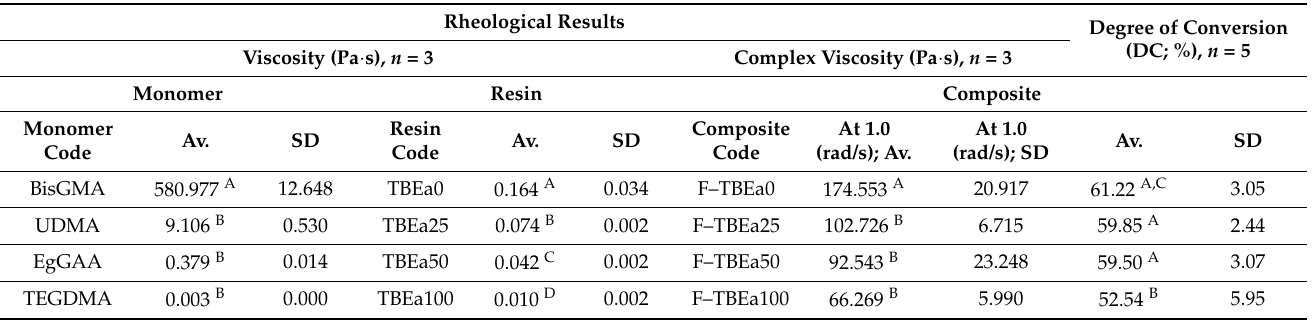
Table 2. Rheological results for monomers (BisGMA, UDMA, EgGAA, and TEGDMA), unfilled resins (TBEa0–TBEa100), and silica filled resin-based composites (F-TBEa0–F-TBEa100), and degree of conversion (DC) of filled